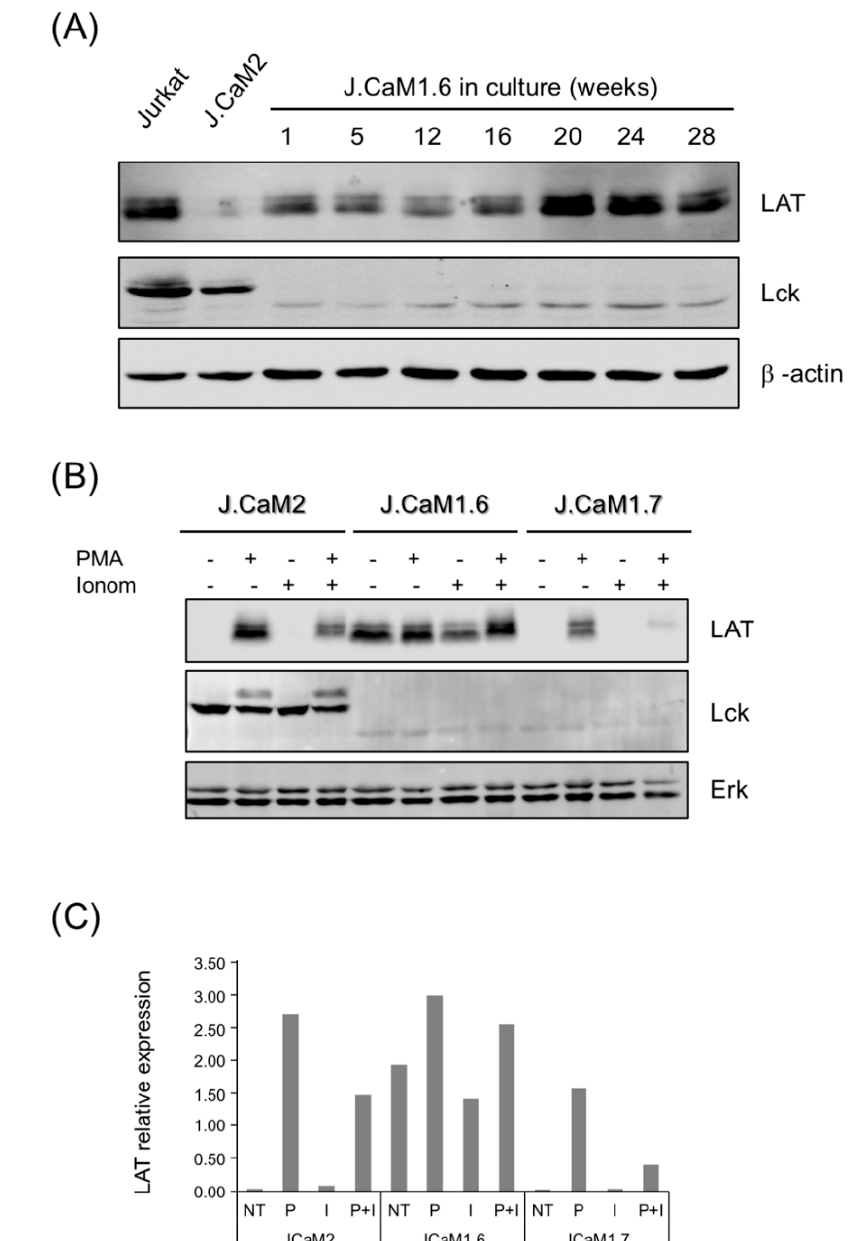
Figure 2. Stability and induction of LAT expression in J.CaM1.6 and J.CaM1.7 cells. ( A ) J.CaM1.6 cells were grown at 37 °C and 5% CO 2 continuously after thawing for the indicated weeks, and then cell lysates were obtained and analyzed for LAT, Lck, and β -actin expression by Western blot. Lysates obtained from Jurkat and J.CaM2 were incorporated as positive and negative controls. ( B )